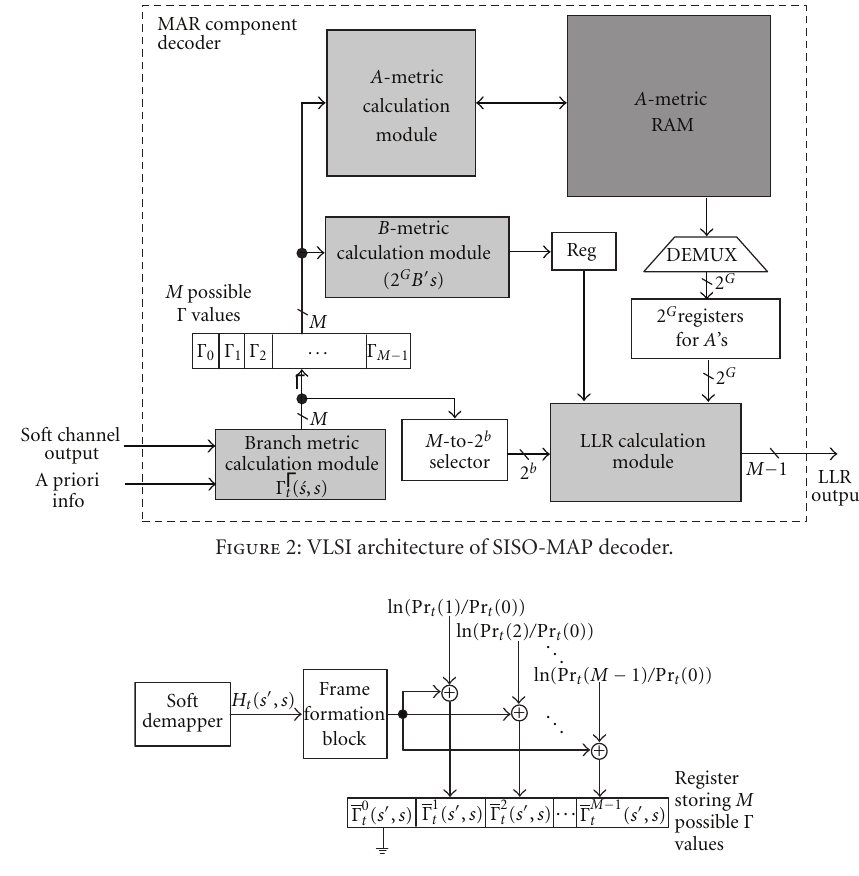
Figure 3: Branch metric calculation module.